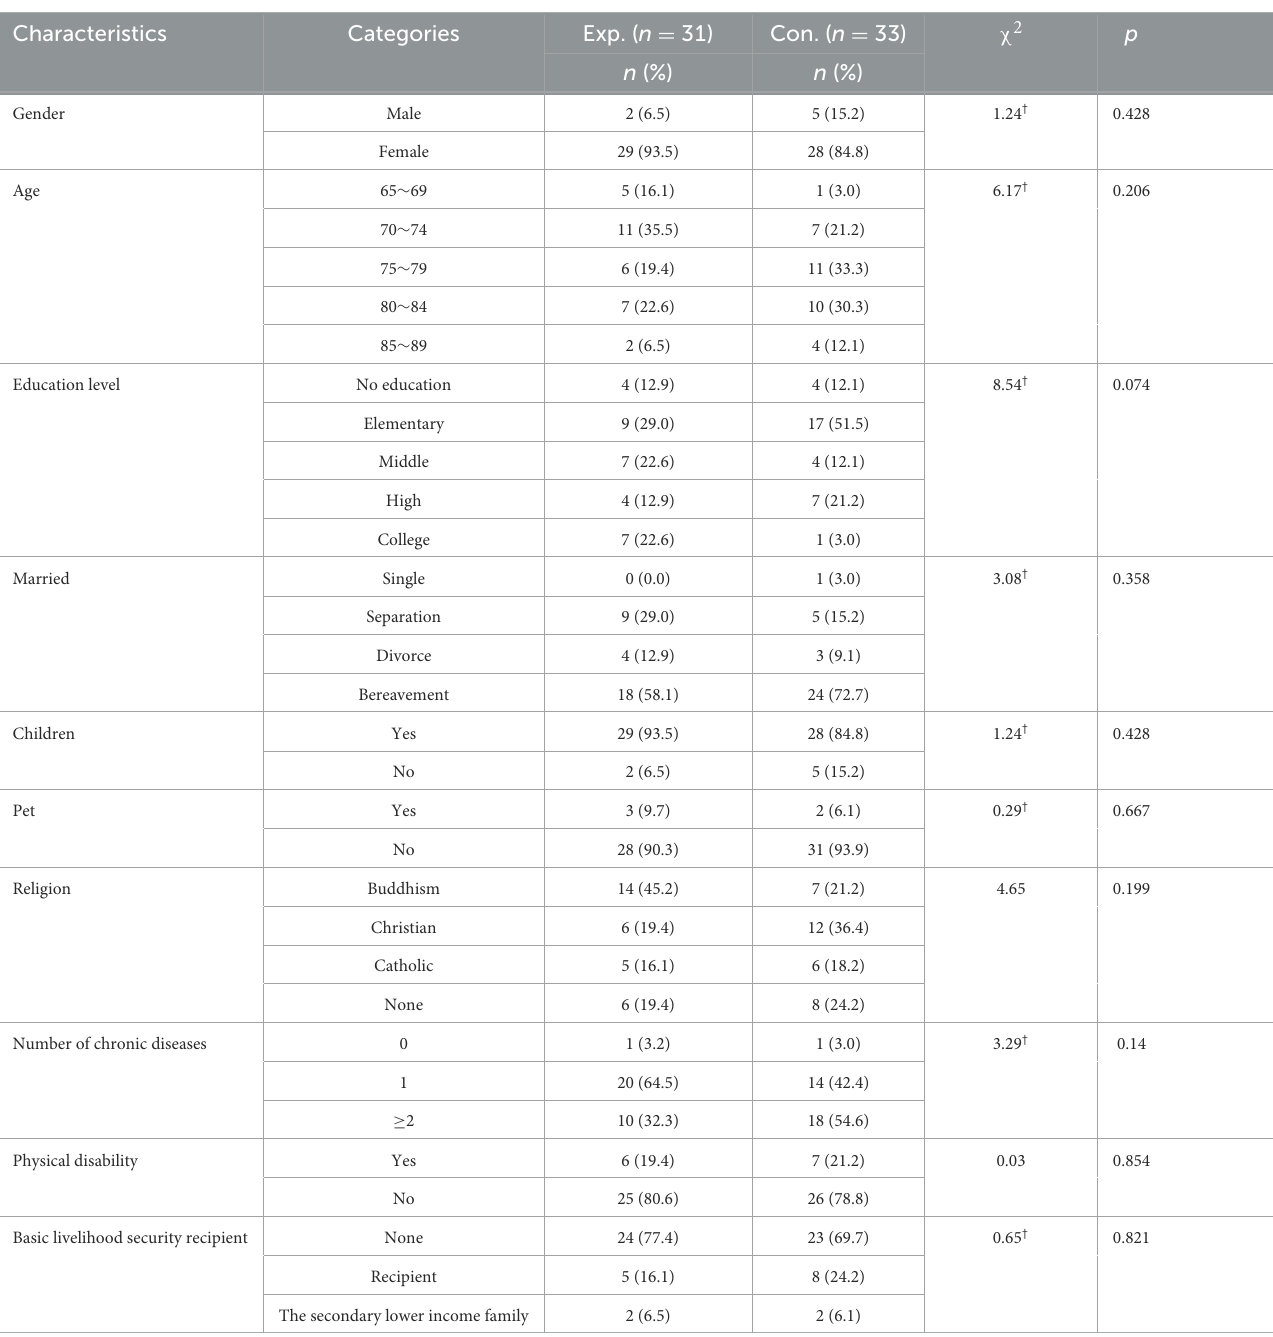
TABLE 2 Homogeneity test of general characteristics ( N =